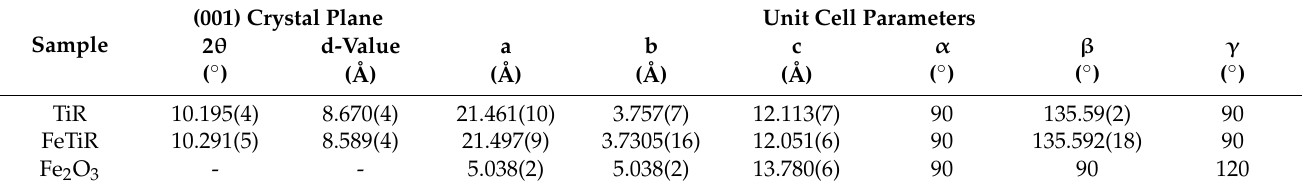
Table 1. The structure parameters.